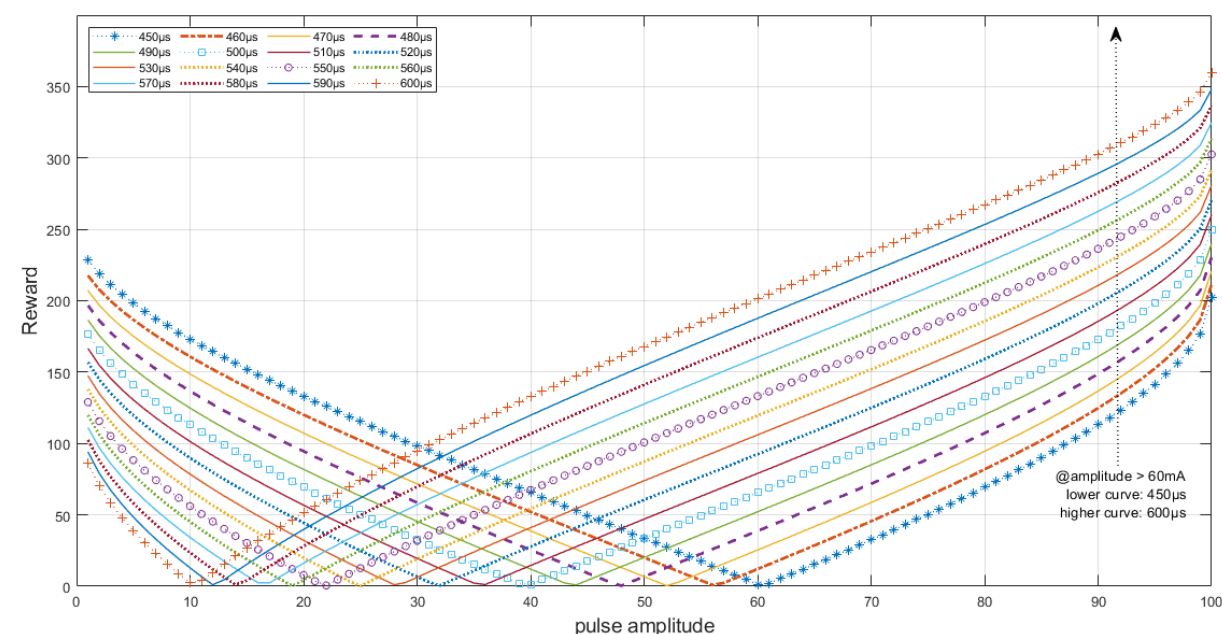
Figure 2. Reward curves relating amplitude and pulse width prioritization. At lower amplitudes, narrower pulse widths return higher rewards as it is preferable to decrease the stimulation cost; at higher amplitudes, the agent is expected to perceive greater rewards as the pulse width increases. The reward must also be related to the average cadence error, however.